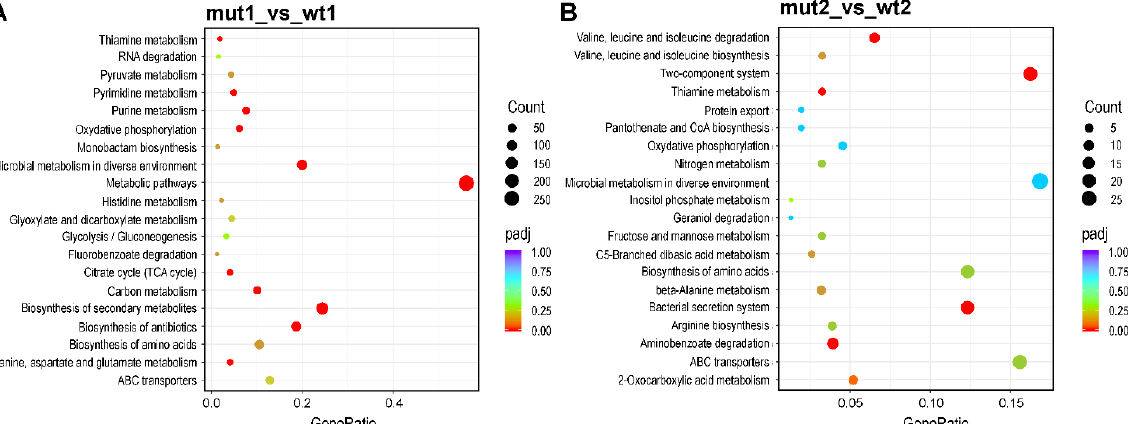
Figure 4. KEGG enrichment analysis of detected DEGs. The top 20 enriched KEGG pathways of DEGs in exponential ( A ) and stationary ( B ) growth phase. The x-axis represents the gene ratio, ratio of DEGs in pathway to the total number of annotated genes in the pathway. The value of gene ratio is proportional to the degree of enrichment. The size of the dots indicates the number of DEGs in each pathway, while the dot color represents corrected p values. The color vicinity to red is proportional to the enrichment significance.